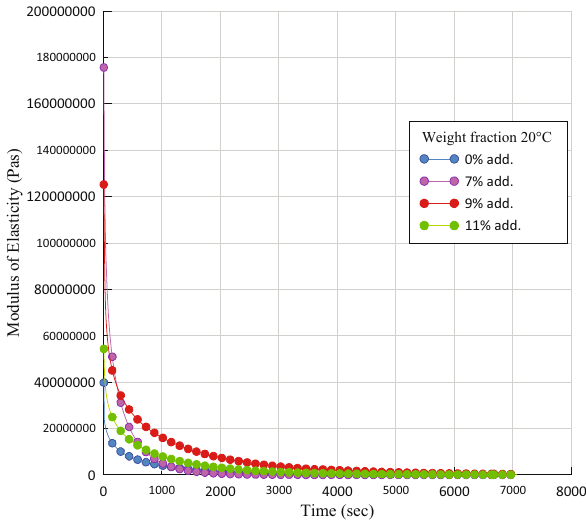
Figure 10: Stress versus time for UP/PS reinforced with fi sh fl akes for di ff erent weight fractions at 20°C.